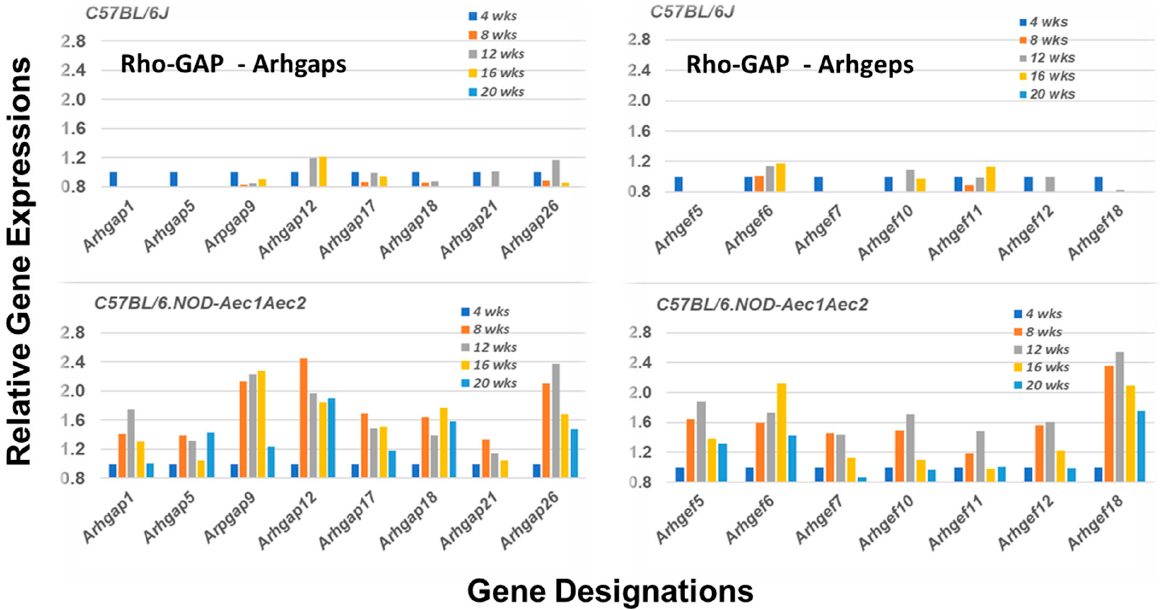
Figure 4. Unique upregulation profiles for genes encoding for members of the Rho-GTPase GAP and GEF families of proteins. Transcriptome data showing the temporal expressions of 8 of the 23 Arhgap genes and 7 of the 17 Arhgef genes upregulated in the salivary glands of C57BL/6.NOD- Aec1Aec2 mice ( lower panels ). In each case, upregulated expressions started around 8 weeks of age. In contrast, expressions of these Arhgap and Arhgef genes remain downregulated.